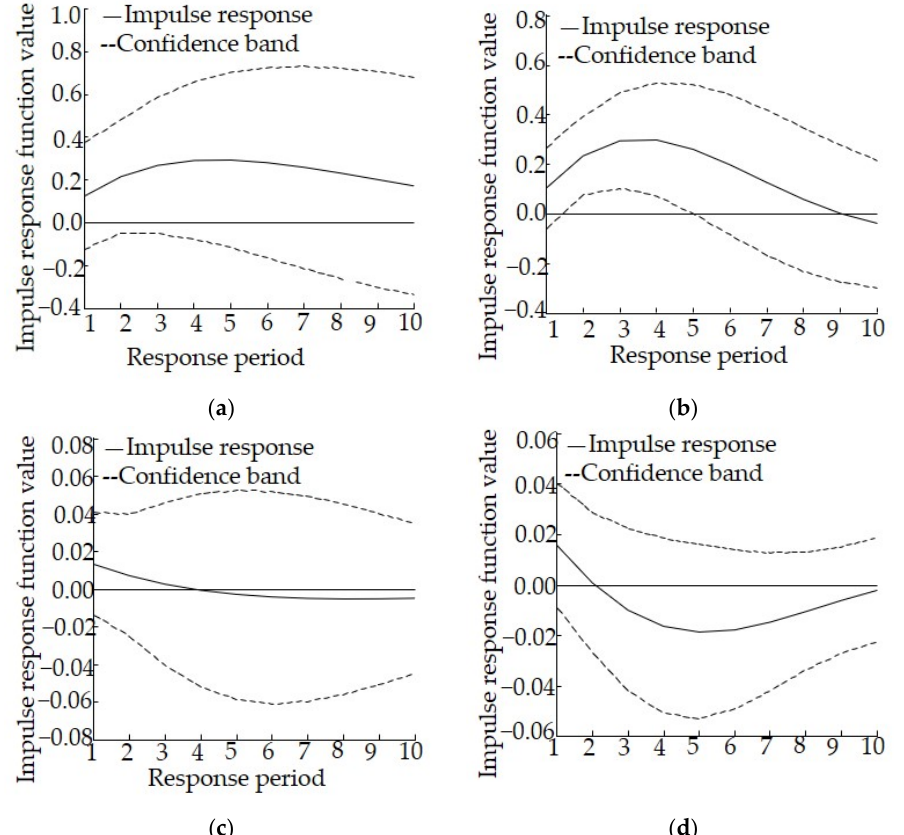
Figure 6. Impulse response relationship between industrial structure adjustment and the discharge of pollutants to the aquatic environment in Xinjiang, ( a ) Impulse response of lnCOD to lnSI, ( b ) Impulse response of lnAN to lnSI, ( c ) Impulse response of lnSI to lnCOD, ( d ) Impulse response of lnSI to lnAN. Table 8. Forecast variance decomposition of the discharge of pollutants to the aquatic environment in response to industrial structure adjustment in